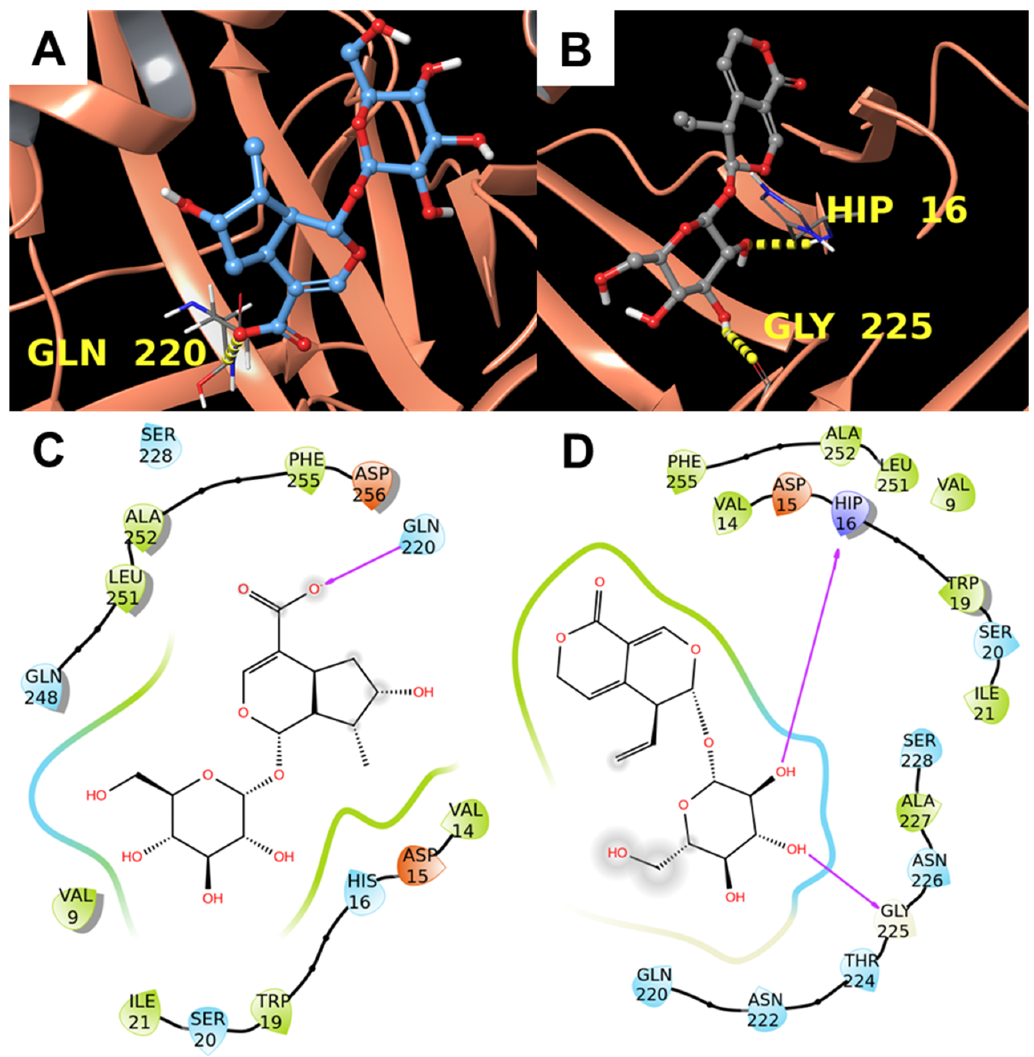
Figure 3. Molecular docking results. ( A – B ) 3D binding mode of 1 ( A ) and 2 ( B ) with alpha-1-antichymotrypsin (PDB: 5OM2 [41], orange ribbons). Hydrogen bonds are represented by yellow dotted lines. ( C – D ) 2D representation of the binding pose of 1 ( C ) and 2 ( D ). Pink arrows represent hydrogen bonds.